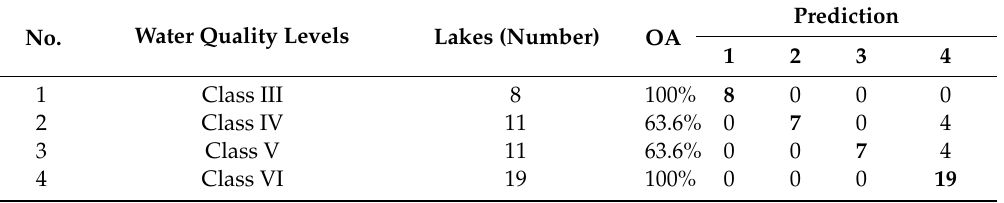
Table 9. The statistics of the prediction results for the water quality levels in each lake for the Huangshi